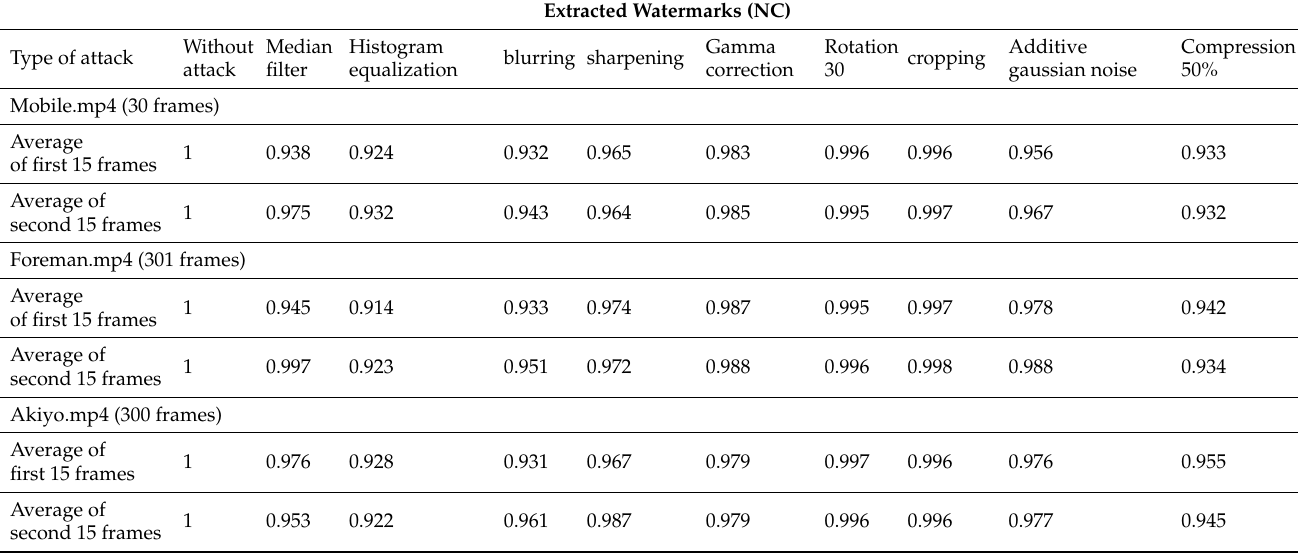
Table 4. Extracted watermark and NC value under various attacks. Extracted Watermarks (NC)